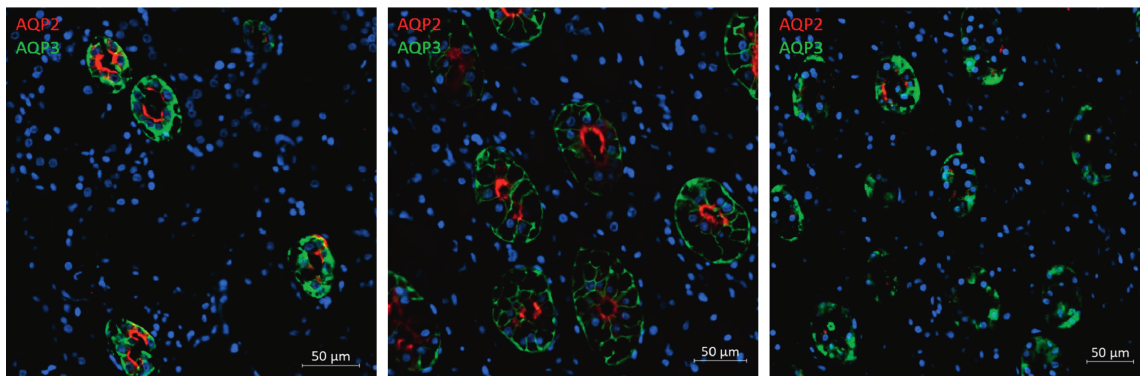
Figure 2: Representative pictures of double immunostaining with anti-aquaporin-3 (AQP3; green channel) and anti-aquaporin-2 (AQP2; red channel) antibodies in kidney sections from a control patient (left), a patient with severe COVID-19 (middle), and a patient with severe COVID-19 and sevoflurane-associated nephrogenic diabetes insipidus (right). Nuclei are stained with DAPI (4 ′ ,6-diamidino-2-